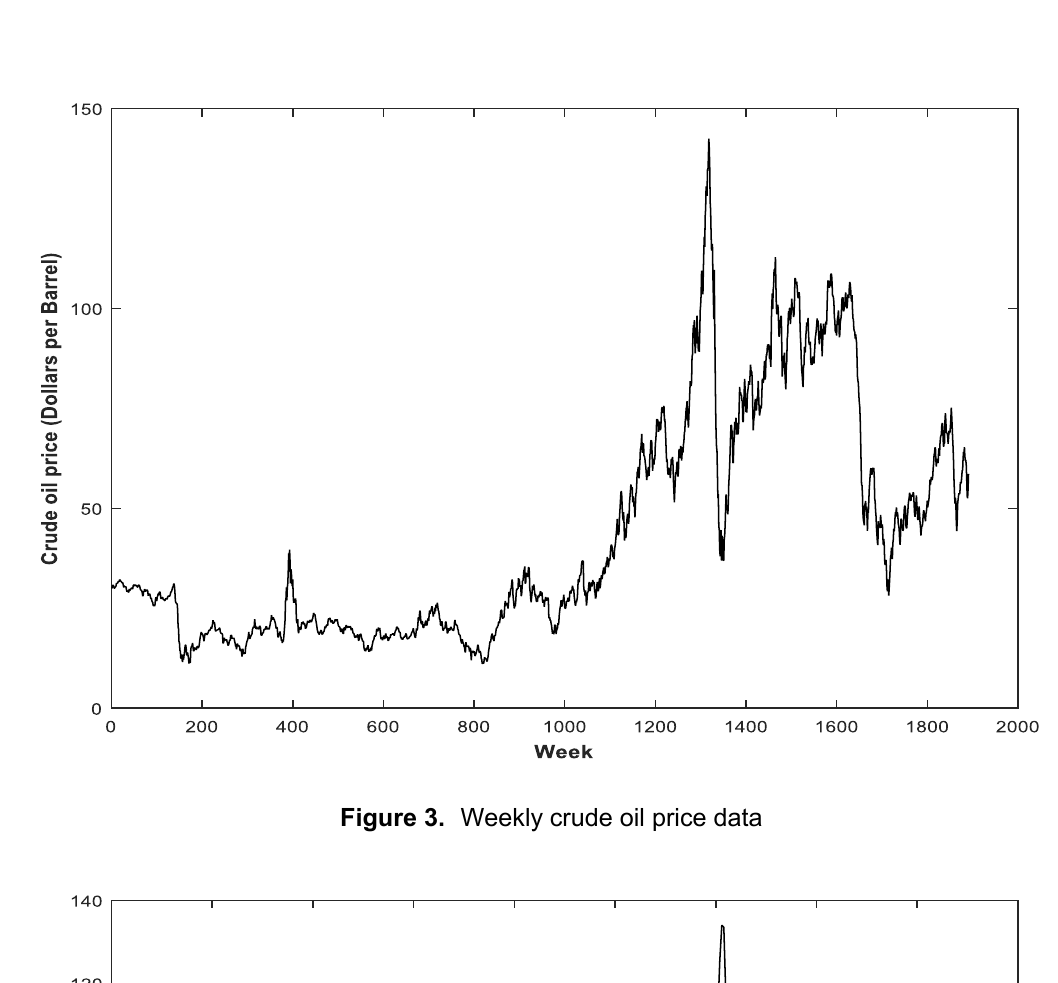
Figure 3. Weekly crude oil price data